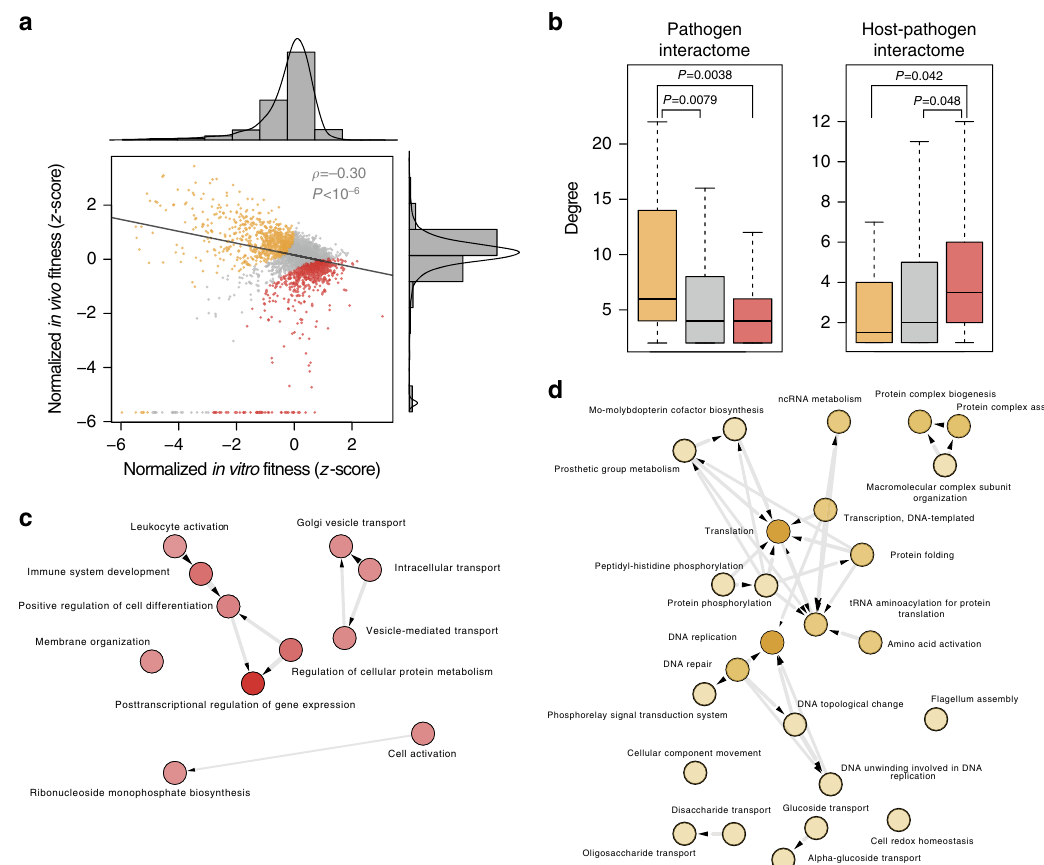
Figure 2 | Analysis of fitness shifting during Y. pestis infection. ( a ) Representation of in vivo against in vitro fitness z -scores (calculated according to z ¼ x (cid:2) m ð Þ = s ). Proteins that rank 2.5 times higher in vivo than in vitro are coloured red while those ranking 2.5 times lower are coloured orange. The remaining proteins (that is, those whose rank does not change) are coloured grey. Spearman rank order correlation is shown. ( b ) Boxplots showing the average node degree in the pathogen (left) and host–pathogen (right) interactome for the three aforementioned categories. P -values were calculated using the Mann–Whitney U -test. Changing the threshold in the definition of orange, grey and red groups did not have a significant effect (for 2 o threshold o 3 calculated P -values were always significant). GO molecular function enrichment is plotted for interactors in the red ( c ) and orange ( d ) groups. For the red group, enrichment was calculated over the complete list of host interactors to avoid potential biases while for the orange group it was done over the complete Y. pestis proteome. GO categories were grouped using Revigo and plotted with Cytoscape as described in the Methods section. In box plots, the bottom and top represent the 25th and 75th percentile (i.e. lower and upper quartiles) and the centre line represents the median. The